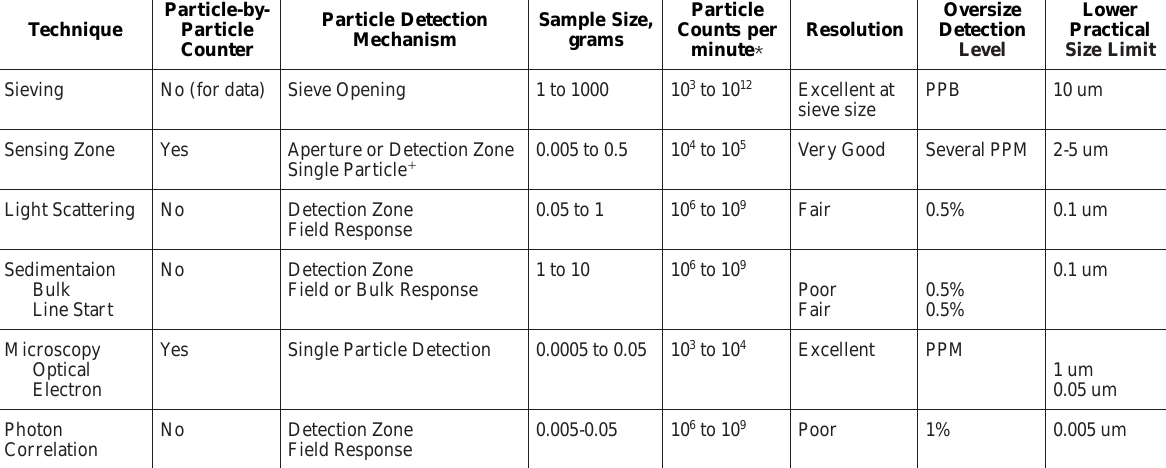
* Particle counting statistics increase per time increment as size of powder decreases. + Single-particle detection response only if samples are sufficiently